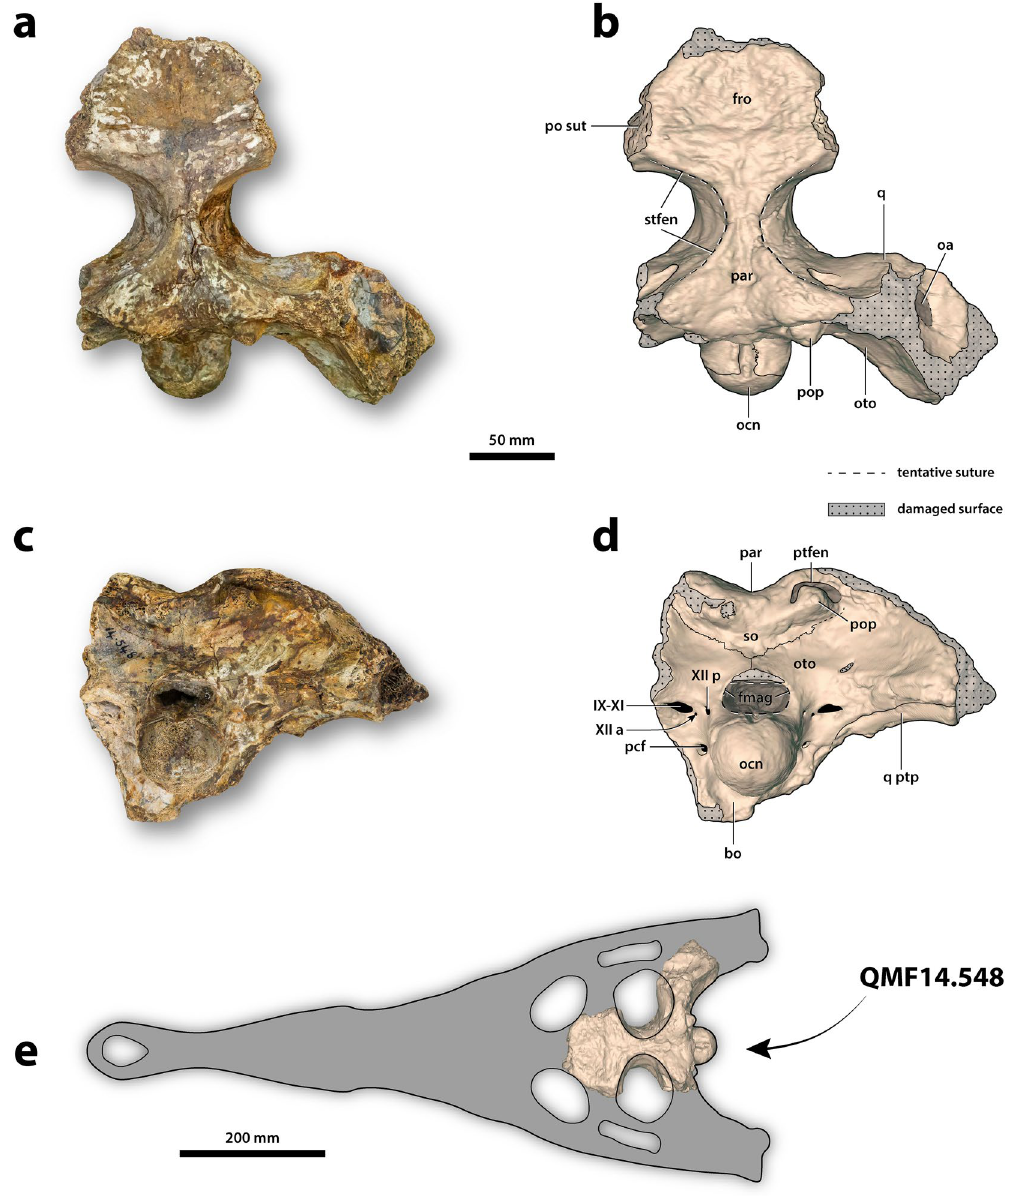
Figure 2. Gunggamarandu maunala gen. et sp. nov., QMF14.548, holotype. ( a ) Photograph, and ( b ) annotated digital model of the cranium in dorsal views. ( c ) Photograph, and ( d ) annotated digital model of the cranium in occipital views. ( e ) Hypothetical outline of the skull of Gunggamarandu maunala in dorsal view, with QMF14.548 depicted in its corresponding position. The hypothetical skull outline of Gunggamarandu maunala in ( e ) is based on the skulls of Dollosuchoides densmorei and Kentisuchus spenceri . bo, basioccipital; fmag, foramen magnum; fro, frontal; IX-XI, foramen for glossopharyngeal, vagus, and accessory nerves (metotic foramen); oa, otic aperture; ocn, occipital condyle; oto, otoccipital; par, parietal; pcf, posterior carotid foramen; po sut, sutural surface for articulation with the postorbital; pop, postoccipital process of the supraoccipital; ptfen, posttemporal fenestra; q, quadrate; q ptp, quadrate pterygoid process; so, supraoccipital; stfen, supratemporal fenestra; XII a, anterior hypoglossal foramen; XII p, posterior hypoglossal foramen. This figure was created by J. R. in Adobe Illustrator CC 2021 (https:// www. adobe. com/ produ cts/ illus trator.